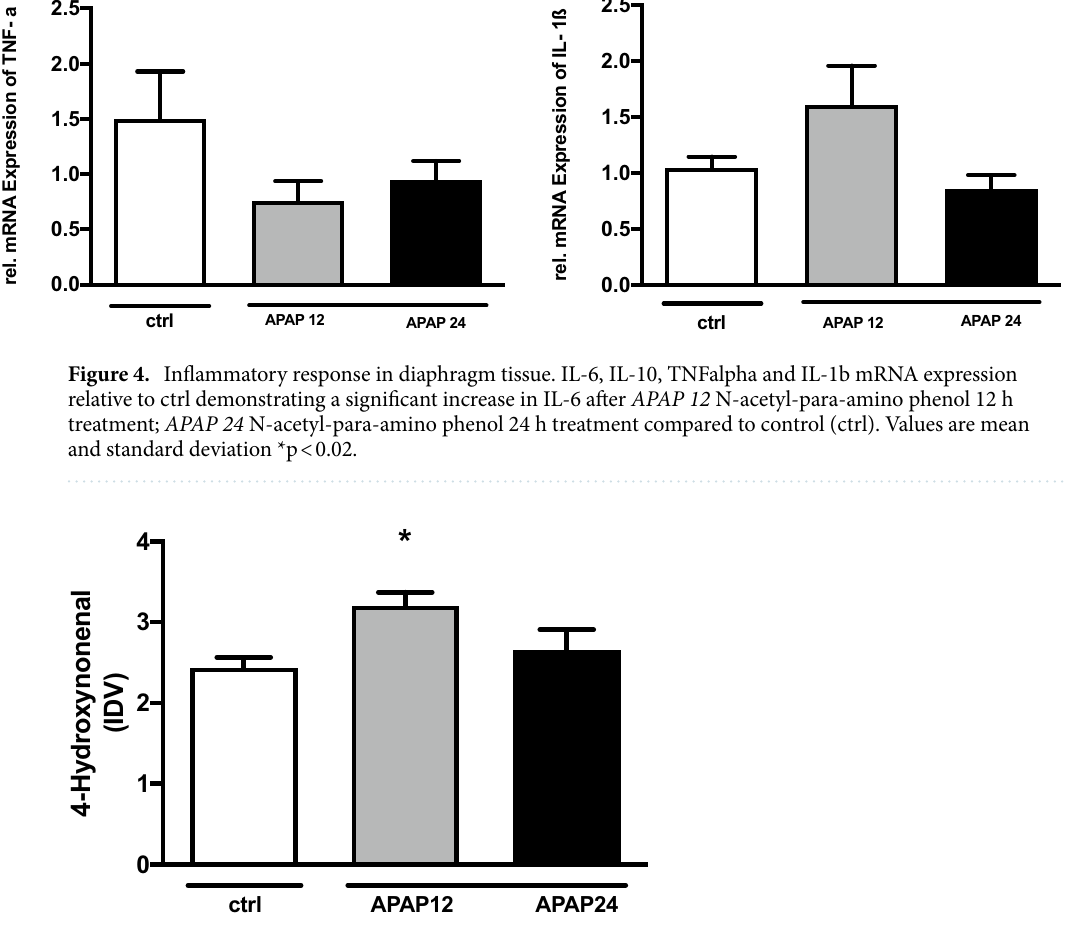
Figure 5. Lipid peroxidation in diaphragm tissue in interventional groups and control animals. 12 h after APAP exposure, there is a significant increase in lipid peroxidation. 4-HNE 4-Hydroxdy-non-enal, APAP 12 N-acetyl- para-amino phenol 12 h treatment, APAP 24 N-acetyl-para-amino phenol 24 h treatment, ctrl controls; Data are normalized by vinculin and expressed as mean and SD. IDV integrated density value; *indicates significance p <